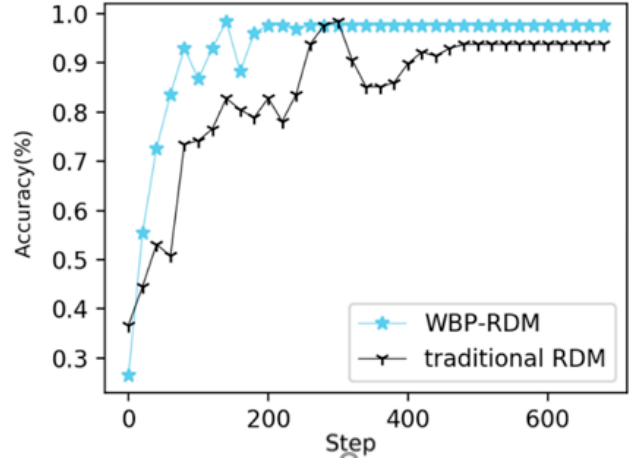
Figure 14. Accuracy of different types of RDMs.